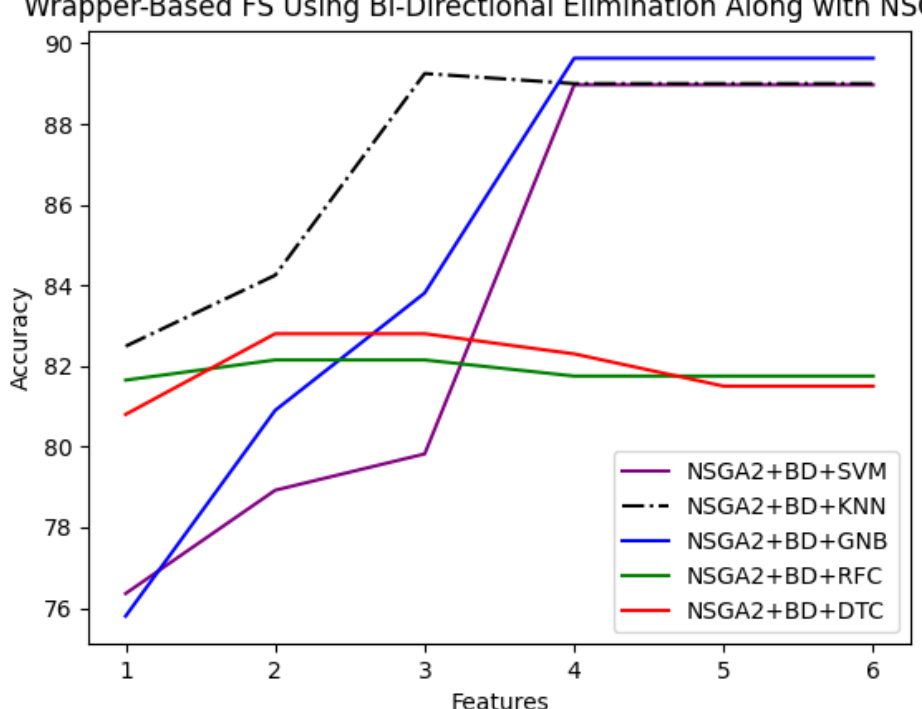
Figure 6. Performance of the five classifiers developed with subset features selected by NSGA2 + Bi-directional.